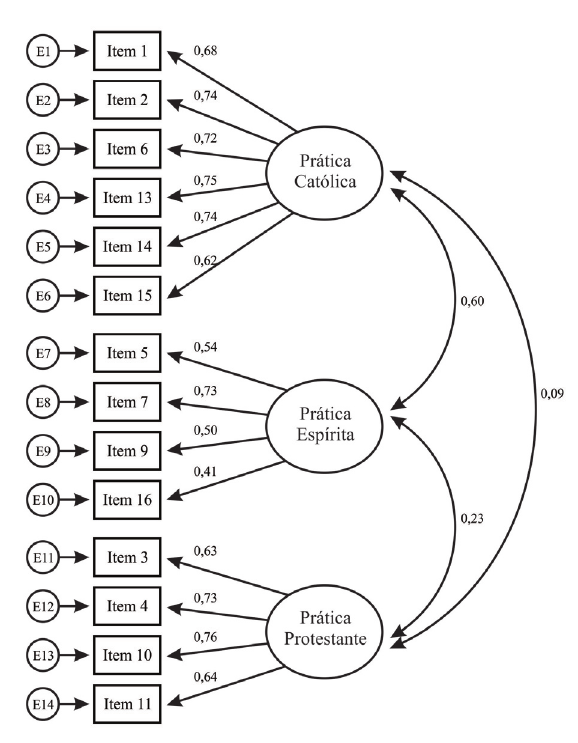
Figura 2 . Estrutura multifatorial da Escala de Práticas Reli-